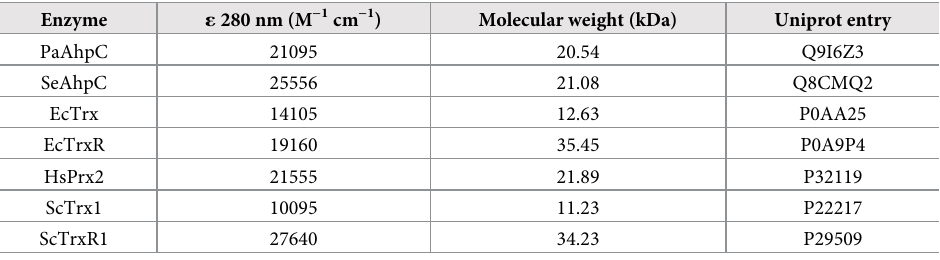
Abbreviations: PaAhpC = P . aeruginosa AhpC, SeAhpC = S . epidermidis AhpC, EcTrx = E . coli Trx1; EcTrxR = E . coli TrxR1, HsPrx2 = H . sapiens Prx2, ScTrx1 = S . cerevisiae Trx1 and ScTrxR1 = S . cerevisiae